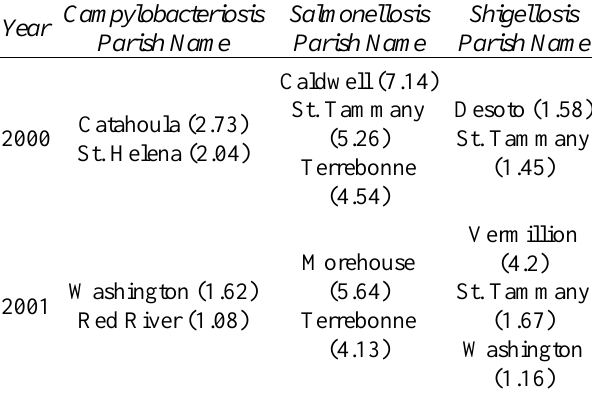
Table 1: Highest infection rates per number of cases for campylobacteriosis, salmonellosis, and shigellosis in Louisiana parishes (LDHH 2001).